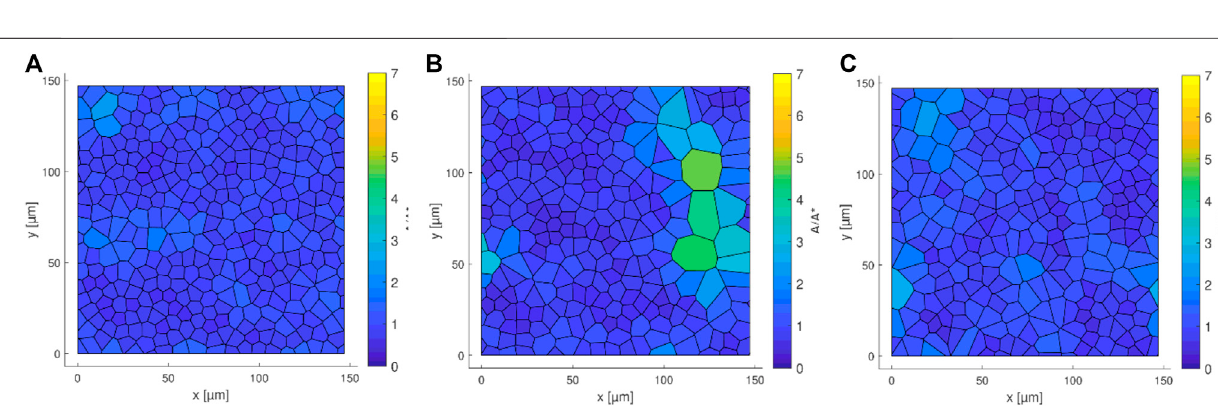
Frontiers in Materials |